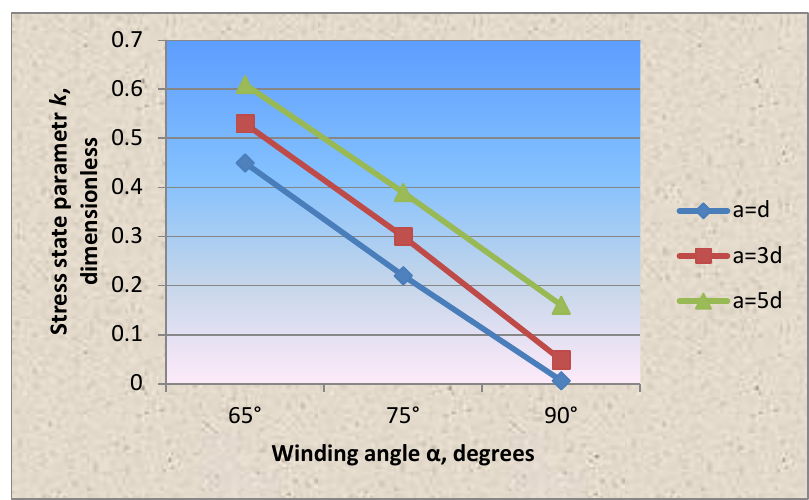
Figure 5. Dependence of the stress state parameter on the winding angle of the wrapping thread with the winding wire diameter of 1.0 mm.